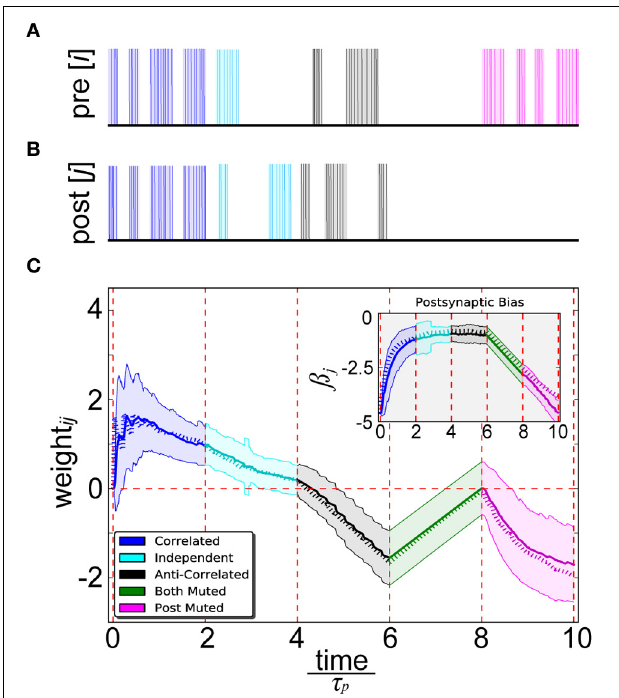
FIGURE 4 | Spike-based BCPNN estimates abstract BCPNN for different input patterns. (A) Pre- and (B) postsynaptic input spike trains. Activation patterns (shaded rectangles) of abstract BCPNN units and corresponding Poisson spike trains (vertical bars) firing at f max Hz elicited in IAF neurons are differentiated by color. (C) Weight and bias (inset) development under different protocol for the abstract (dotted) and spike-based (solid) versions of the learning rule. Spiking simulations were repeated 100 times and averaged, with standard deviations illustrated by the shaded regions.